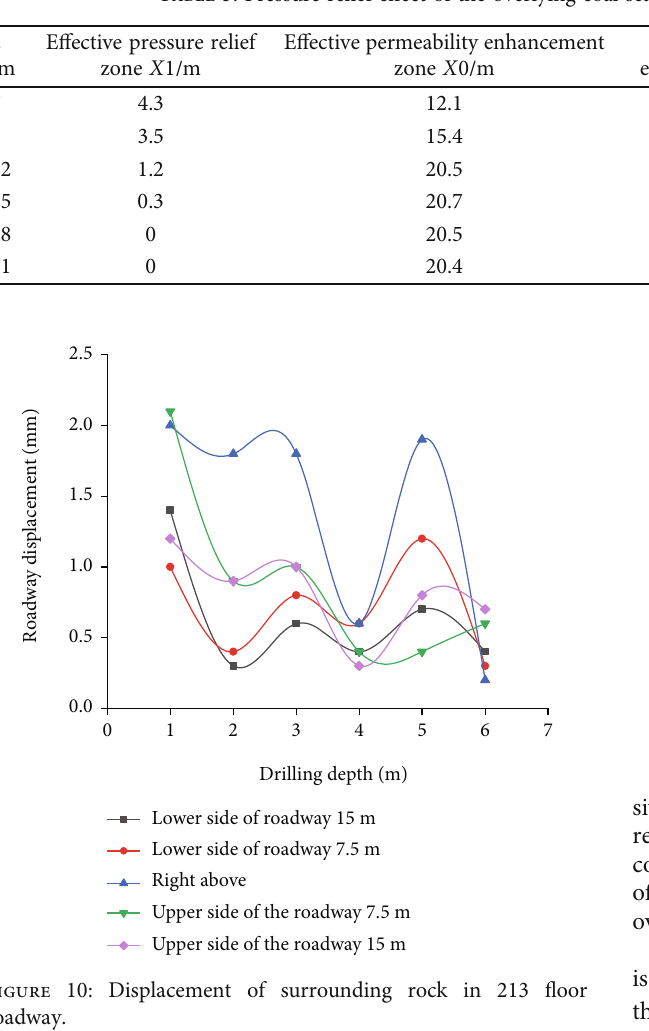
Table 3: Pressure relief e ff ect of the overlying coal seam in the fl oor roadway at di ff erent positions.